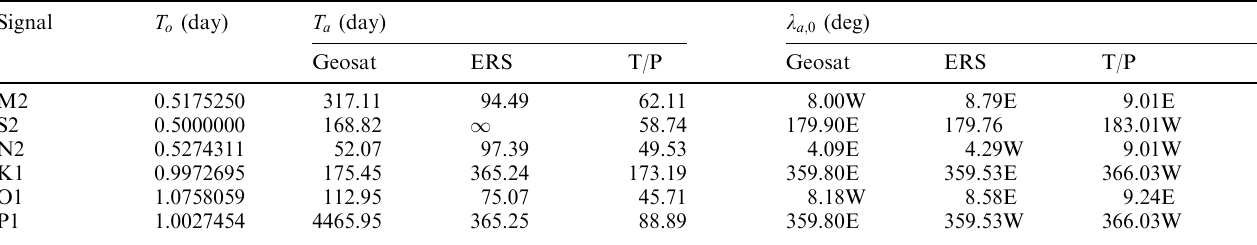
Table 1. Alias periods and primary alias wavelengths of six major tidal constituents under Geosat, ERS (35-day repeat orbit) and TOPEX/ POSEIDON sampling schemes. The direction of alias propagation is denoted as E for east and W for west Signal